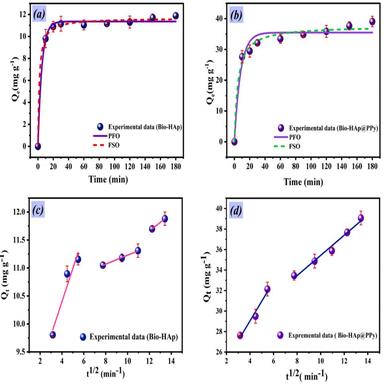
Non-linear kinetic plot for Bio-HAp (a) and Bio-HAp@PPy nanocomposite (b); Intraparticle diffusion plot for Bio-HAp (c) and Bio-HAp@PPy nanocomposite (d).